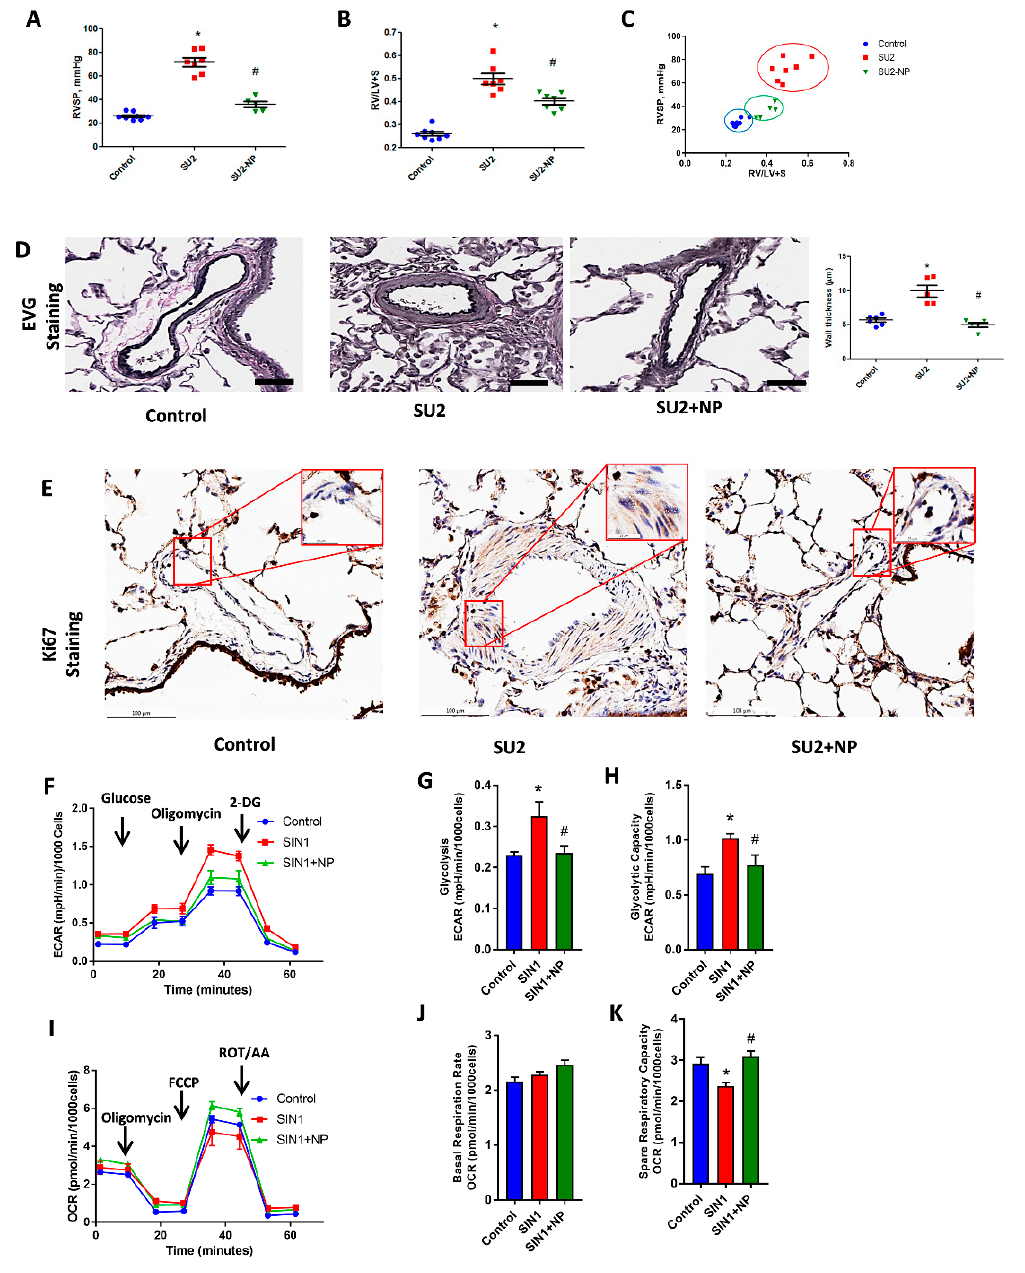
Figure 4. NP controlled hemodynamic and histological alterations. ( A ) Right ventricular systolic pressure (RVSP) was significantly increased in SU2, and NP treatment showed a reduction in RV pressure. ( B ) Fulton index, the ratio of right to left ventricles plus septum (RV/(LV+S)), was significantly increased in SU2 and markedly decreased in NP treatment. ( C ) Correlation analysis between RVSP and Fulton index showed a significant attenuation of the PAH phenotype in NP treatment. ( D ) Clastic Verhoeff–Van Gieson (EVG) staining exhibited perivascular fibrosis, vasoconstriction, and proliferation in pulmonary arteries of SU2, and these alterations were significantly attenuated with NP treatment (scale is 100 µm). ( E ) Ki-67 immunohistochemical staining showed increased cellular proliferation in the media of the pulmonary artery in the SU2 group, and NP effectively prevented vascular remodeling and cellular proliferation (scale is 100 µm). Small box represents magnified images at 25 µm. Data expressed as mean ± SE, N = 4–7, * p < 0.05 versus control,